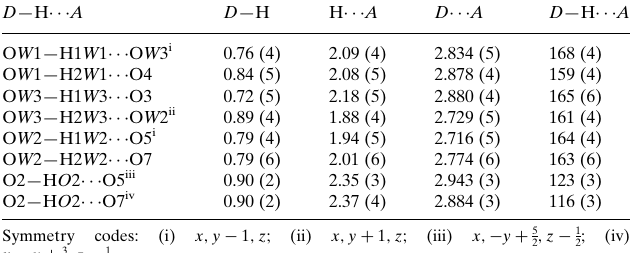
title two-dimensional coordination polymer, independent Cu II atoms is coordinated by a bridging OH group, two O atoms from two benzene-1,3,5-tricarboxylate ( L ) ligands and two N atoms from a 2,2- bipyridine (bipy) ligand in a distorted square-pyramidal geometry. Each L ligand coordinates four Cu II atoms, thus forming a polymeric layer parallel to the bc plane with bipy molecules protruding up and down. The lattice water molecules involved in O—H (cid:2) (cid:2) (cid:2)(cid:2) O hydrogen bonding are situated in the inner part of each layer.